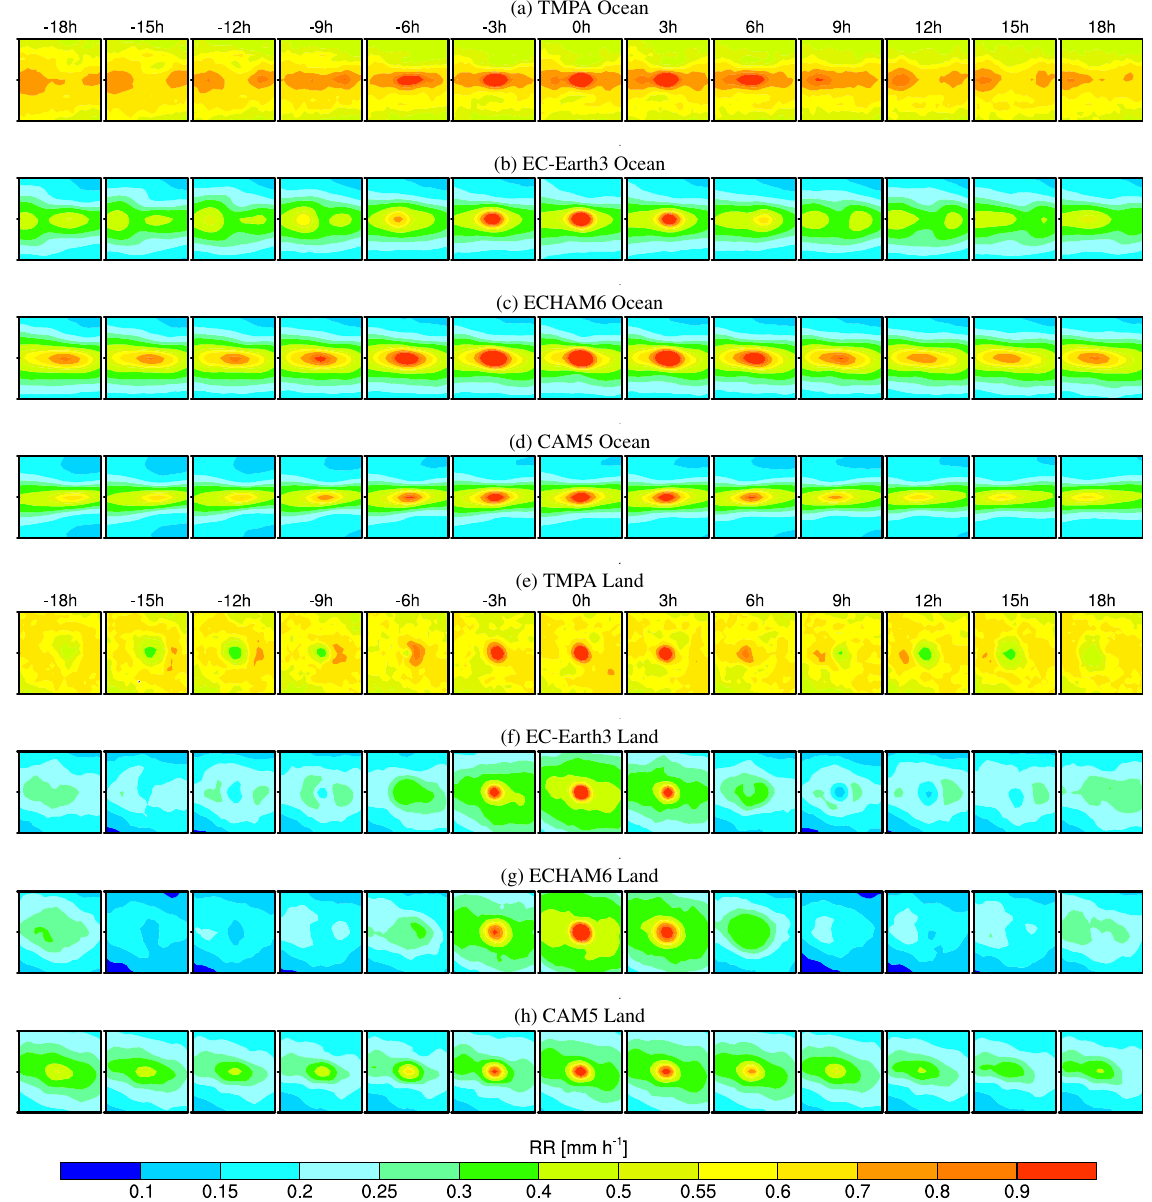
Figure 4. Composite of rain rate for ocean-based (a–d) and land-based (e–h) systems for the Tropical Rainfall Measuring Mission Multi- satellite Precipitation Analysis (TMPA) followed by the models. The spatio-temporal coverage of ± 18 hours at every 3-hour interval and ± 10 ◦ longitude and latitude taken from the centre point and graduated every ± 1 ◦ .